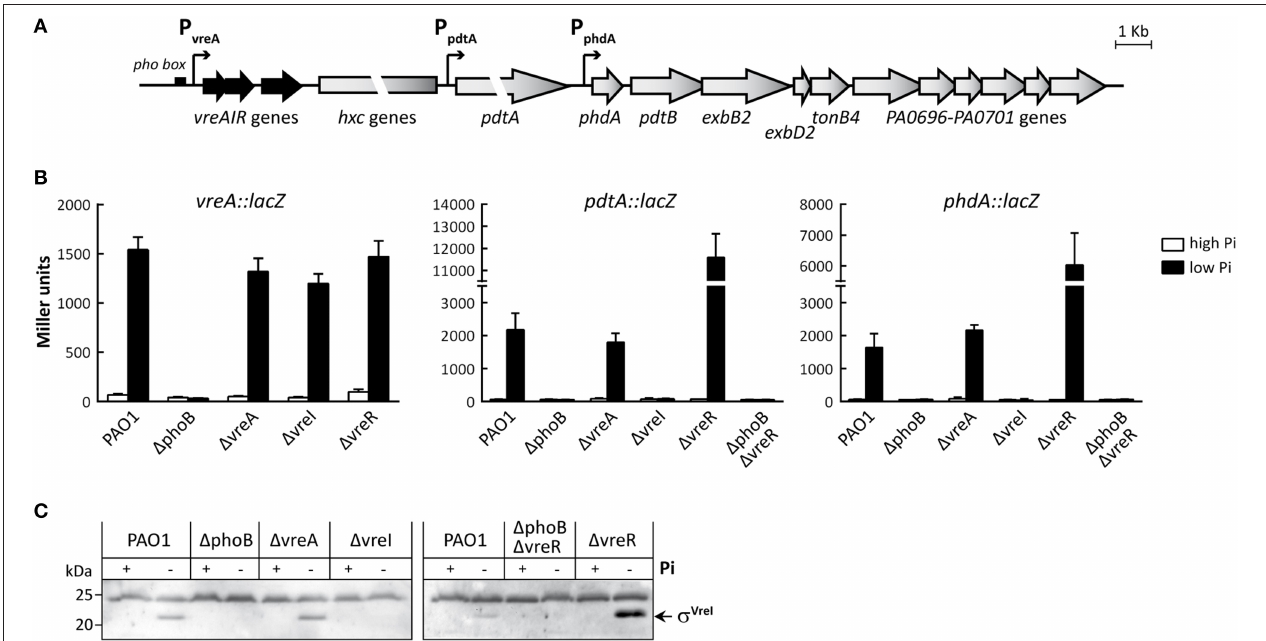
FIGURE 1 | Genetic organization and expression of the PUMA3 regulon. (A) Transcriptional organization of the vreAIR locus encoding the PUMA3 CSS system (black) and the downstream PUMA3-regulated genes (gray). The big arrows represent the different genes, their relative sizes, and their transcriptional orientation. Below each arrow, the name of the gene, gene cluster or the PA number (http://www.pseudomonas.com) is indicated. Small arrows represent the promoters identified within the PUMA3 system (Llamas et al., 2009; Faure et al., 2013). The pho box present in the vreA promoter (Faure et al., 2013) is also indicated. (B) β -galactosidase activity of the P. aeruginosa PAO1 wild-type strain and the indicated mutants bearing the pMP220-derivated plasmids containing the indicated lacZ fusion ( Table 1 ) after 18 h of growth in high or low Pi conditions. (C) Detection of σ VreI in P. aeruginosa PAO1 wild-type strain and the indicated mutants. Proteins were detected by Western-blot using a polyclonal anti-VreI antibody. The positions of the molecular size marker (in kDa) and of the σ VreI protein are